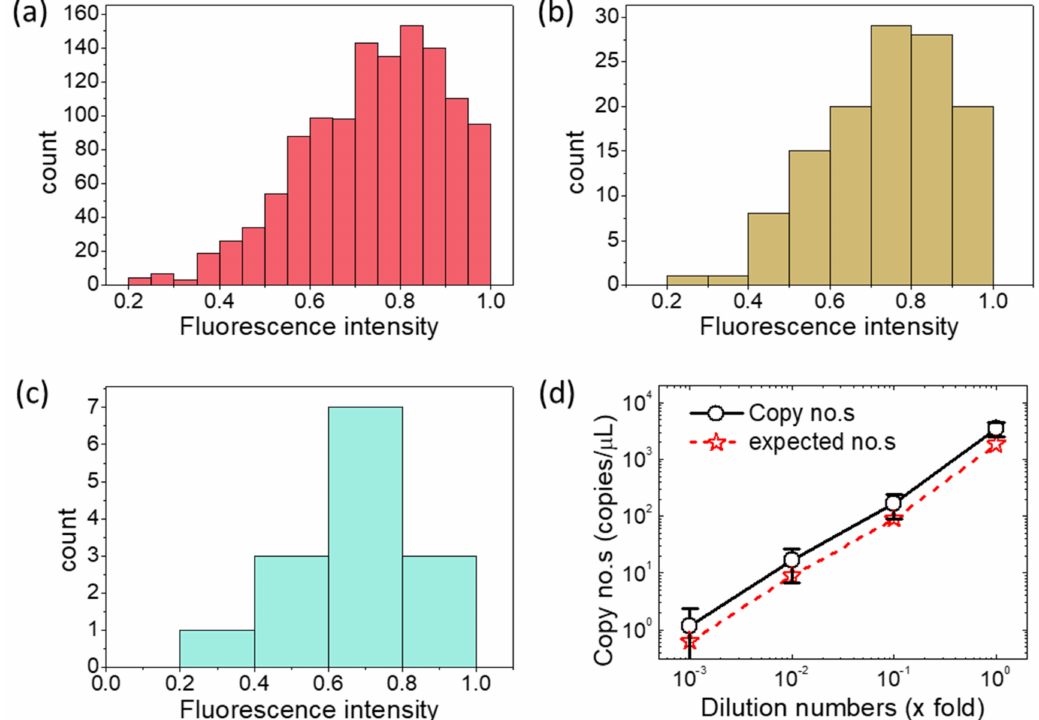
Figure 3. Evaluation of the dPCR microfluidic chip by quantitative analysis. ( a – c ) are histogram plots of original images from the CCD camera, with DNA template concentration of 1 × fold, 0.1 × fold, 0.01 × fold dilutions, respectively. ( d ) is the comparison of expected copy numbers and calculated copy numbers from three independent